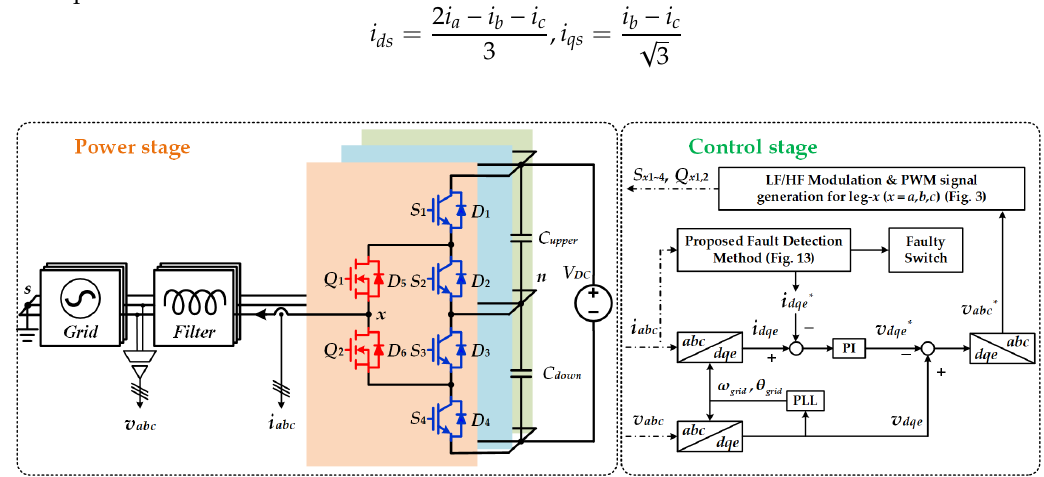
Figure 8. Control diagram for three-phase HANPC rectifier.